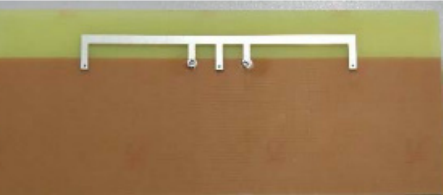
Figure 11. Fabricated two port shared radiator with shorting pins [72].